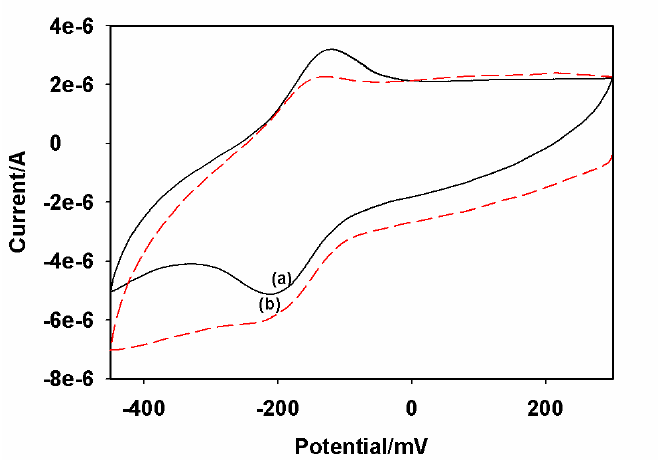
Figure 6. CV’s of AFB blocked) in acetate buffer (pH 6.5): in the absence (a), and presence (b), of 3.2 µM H Scan rate = 10 mV/s.